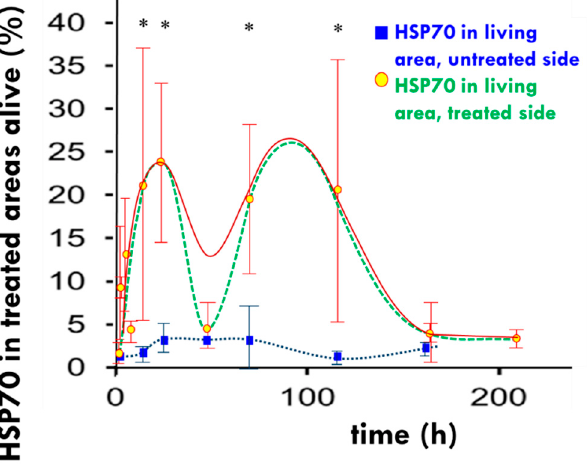
Figure 6. The measured development of HSP70 (dots, solid line). The dual peak pattern represents two types of HSP70. The first is primarily anti-apoptotic connected to the chaperone functions, while the second is pro-apoptotic as a part of the immunogenic cell death. The dashed line approximately represents the two peak separations. The dotted line shows the development of HSP70 in the untreated tumor of the immunocompromised murine HT29 xenograft model. The asterisks on the top indicate significant differences between the HSP70 recorded on the treated side and the untreated side. The curves are for guiding the eye. * p < 0.05.